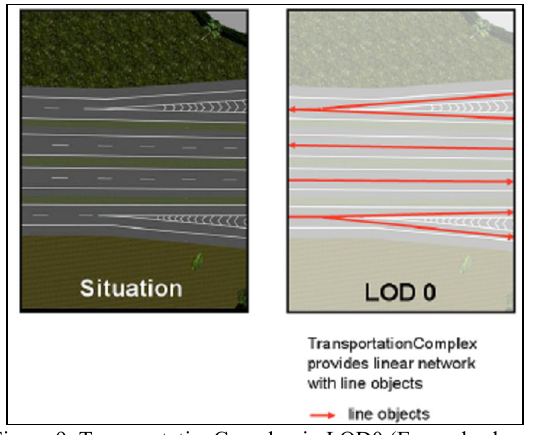
Figure 10. An example line of program code for writing to